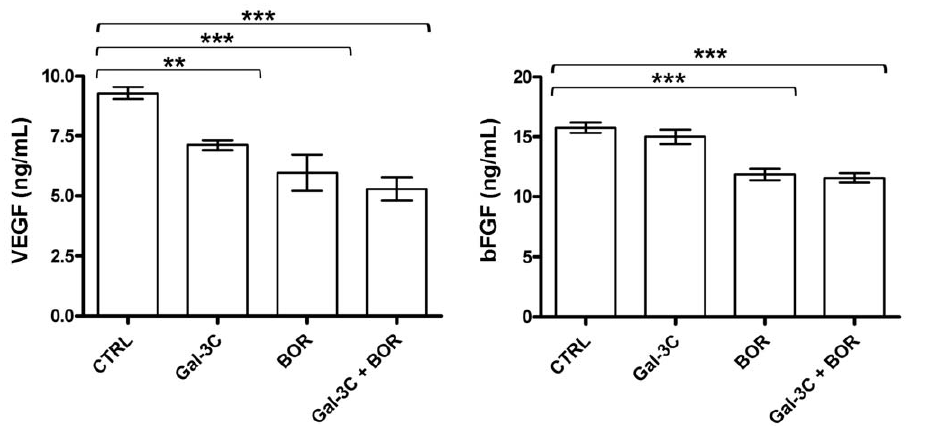
Figure 6. Molecular effects of Gal-3C and Bor on U266 cells. After 48 h in the presence of indicated treatments, the c.m. of U266 cells was diluted 1:2 in ELISA coating buffer and used in a direct ELISA for the measurement of VEGF and bFGF. Histograms represent mean values of 3 independent experiments. Error bars indicate 6 SD. Statistical analysis was performed through one-way ANOVA and Tukey’s post-test: ** P , 0.01; *** P , 0.001.